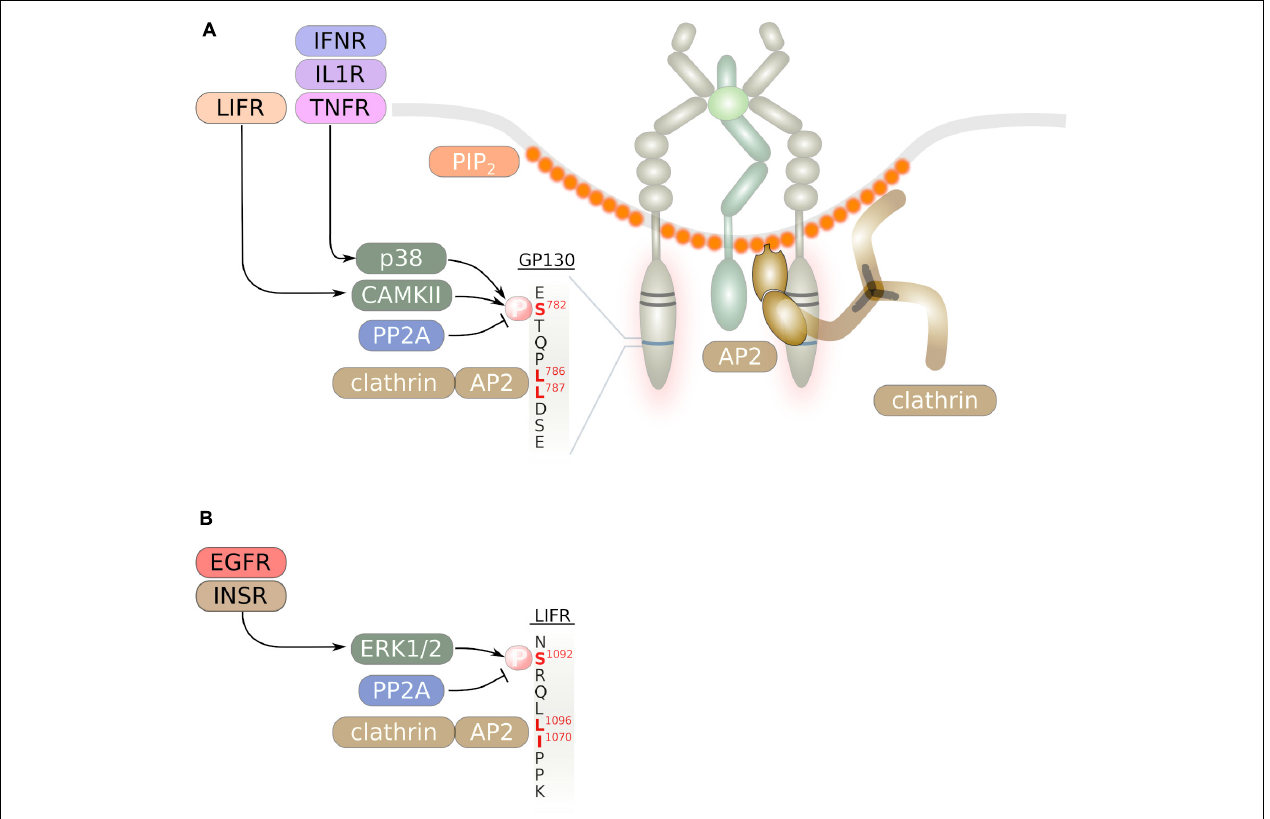
FIGURE 3 | Internalization of IL-6 family signal transducing cytokine receptors occurs via a di-leucin motif. Binding of the adaptor protein complex AP2 to this di-leucin motif and to PIP 2 at the inner leaflet of endocytosis-prone membrane areas initiates formation of clathrin-coated vesicles. The di-leucin motifs of GP130 (A) and the LIFR (B) are shown. Serine phosphorylation in close vicinity to the di-leucin motif is mediated by cytoplasmic serine/threonine kinases and enhances receptor